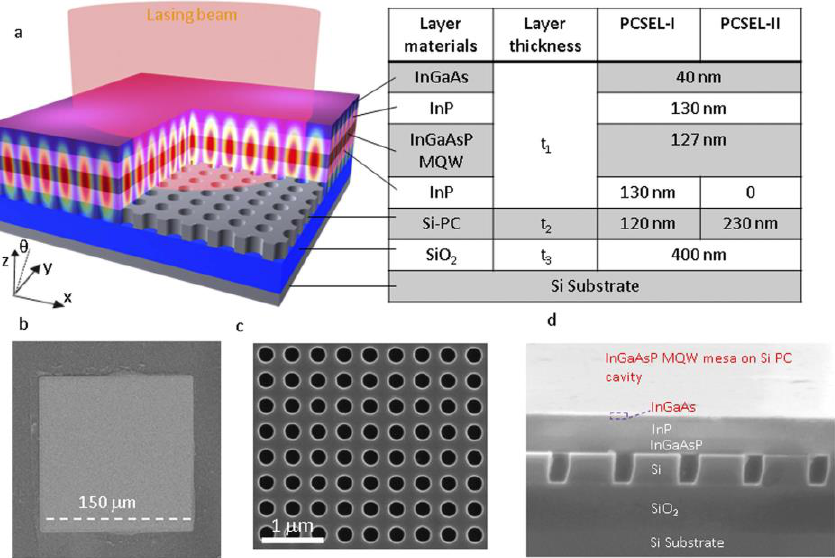
Figure 4. Photonic crystal surface-emitting laser (PCSEL) on silicon. ( a ) Schematic of the hybrid III-V/Si PCSEL cavity on Si substrate, which consists of the III-V active multi-quantum well (MQW) structure and the Si-PC cavity. Also shown is the simulated electrical field distribution in the cavity for a lasing mode at 1424 nm. ( b ) An SEM image of the InGaAsP QW disk/mesa transferred onto a Si-PC. ( c ) Zoomed-in view of the defect-free Si-PC cavity. ( d ) Cross-sectional view of the cavity (reprinted from [30]).